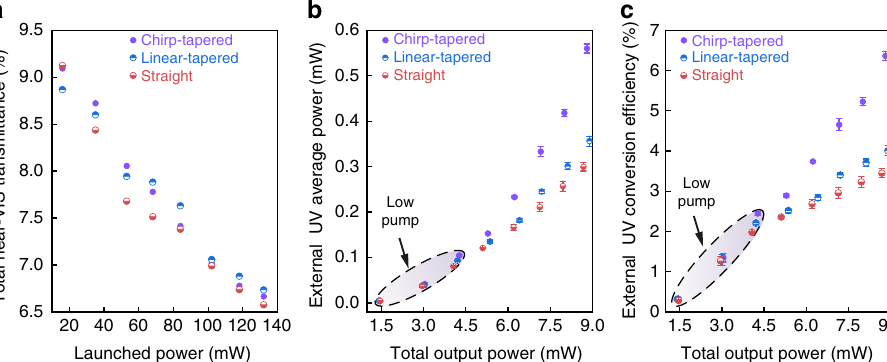
Fig. 3 Ef fi ciency characterization. a – c Performance comparison of chirp-tapered (purple), linear-tapered (blue), and straight (red) AlN waveguides with a total transmittance of near-VIS light, b collected average power of free-space UV light, and c external UV light conversion ef fi ciency. The error bar describes the result variation recorded from other waveguides with the same geometry. In ( b ) and ( c ), the colored shadows reveal the low pump power